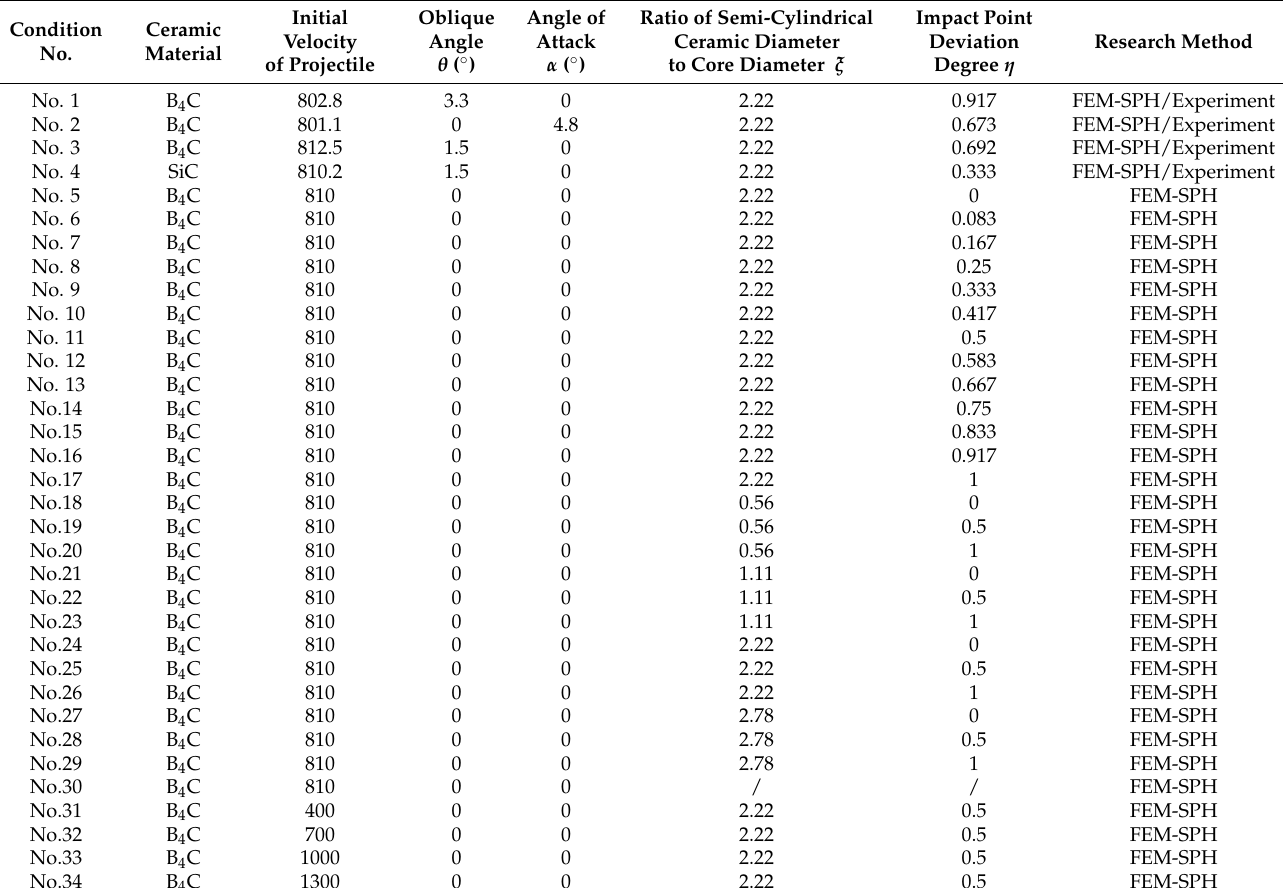
Table 4. Working conditions for